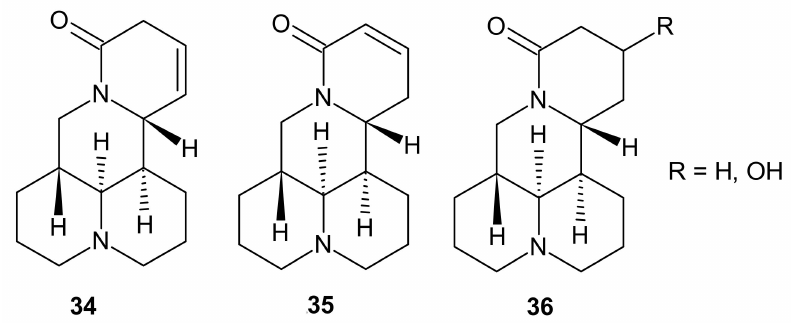
Figure 11. Sophoridine derivatives 34 – 36